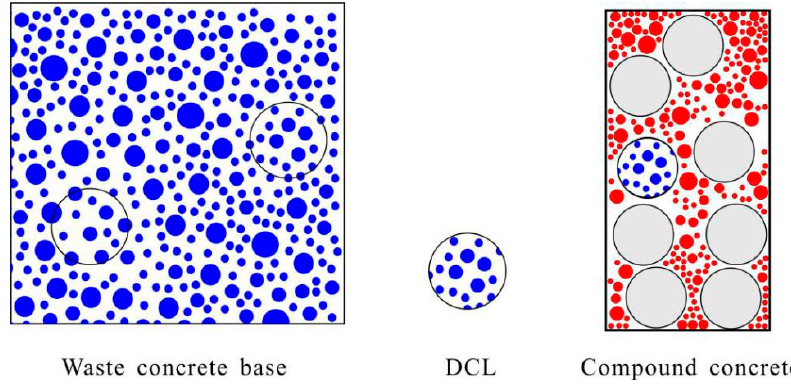
Figure 2. Generating a mesoscale model for recycled lump concrete.